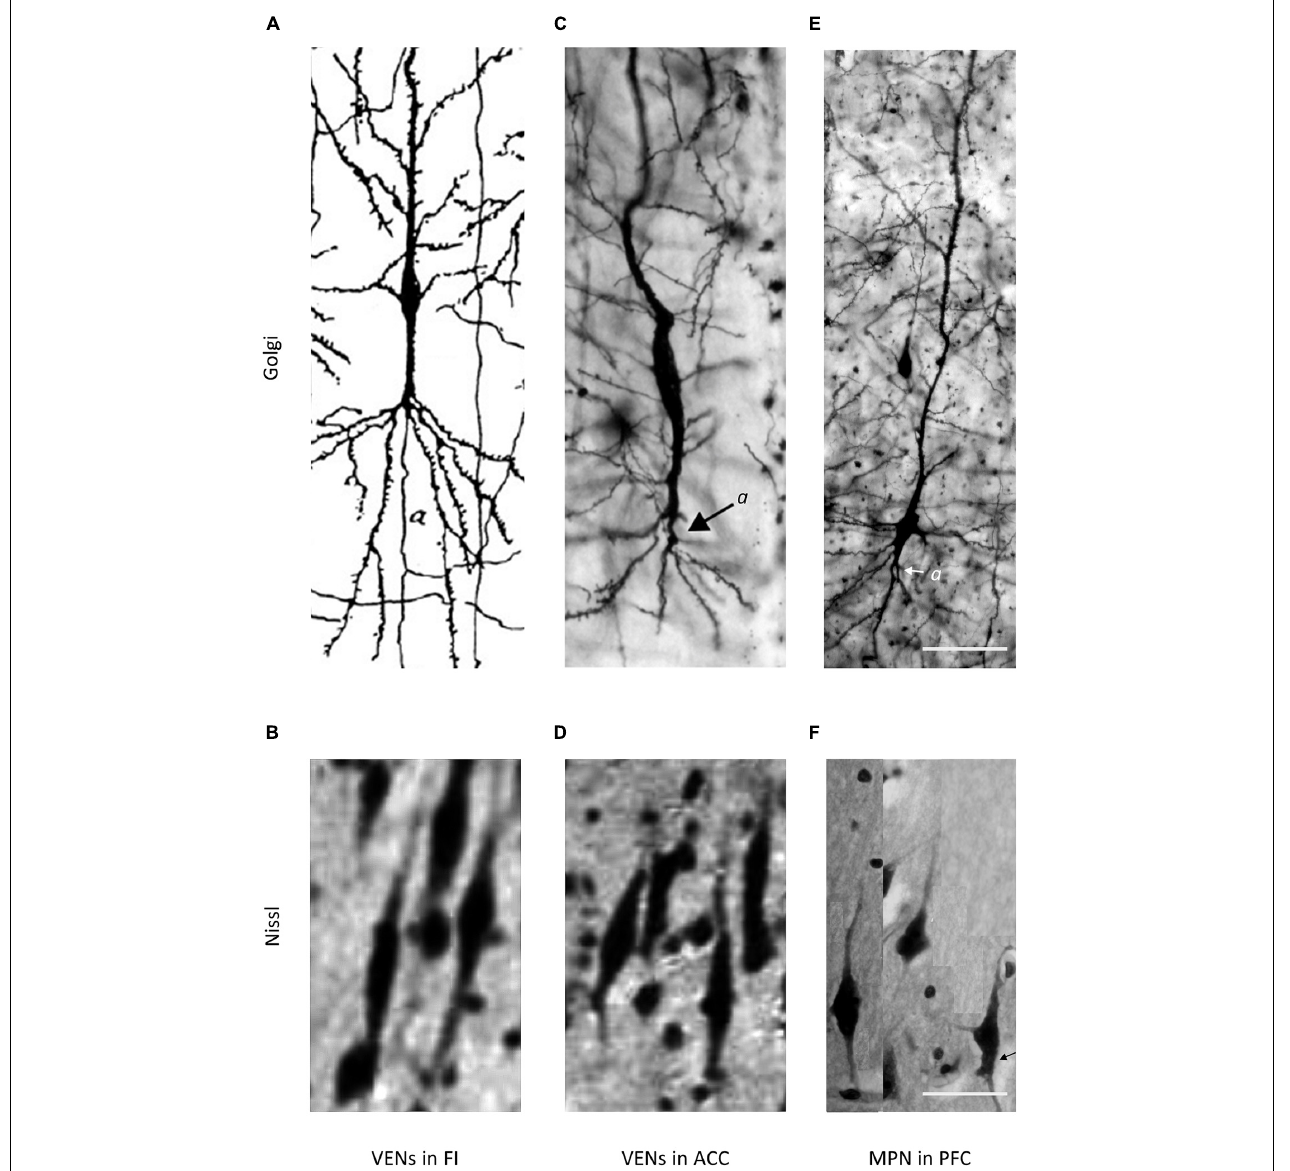
FIGURE 2 | Comparison of VENs and common modified pyramidal neurons (MPN) in the fronto-insular (FI), anterior cingulate cortex (ACC), and PFC on Golgi and Nissl staining. Axons on Golgi staining are marked by “ a ”. The magnification for all microphotographs is indicated by the 50 µ m scale bar in the lower right corner. (A) Drawing of a VEN in the FI of a 1-month-old human, Golgi staining. Image modified from Cajal (1899). Note the distant axon origin and the brush-like terminal branching of the prominent basal dendrite. (B) Microphotograph showing a cluster of VENs in the FI of an adult human, Nissl staining. Image modified from von Economo and Koskinas (1925). (C) Microphotograph of a VEN in the ACC of an adult human, Golgi staining. Image modified from Banovac et al. (2019). Note the distant axon origin and the brush-like terminal branching of the prominent basal dendrite. (D) Microphotograph showing a cluster of VENs in the ACC of an adult human, Nissl staining. Image modified from von Economo and Koskinas (1925). (E) Microphotograph of a common MPN with a spindle-shaped cell body found throughout the PFC, Golgi staining. Image modified from Banovac et al. (2019). Note the axon origin close to the cell body and the lack of the brush-like terminal branching typical for VENs. (F) Microphotograph showing several common MPNs with a spindle-shaped cell body found throughout the PFC, Nissl staining. Image modified from Banovac et al.